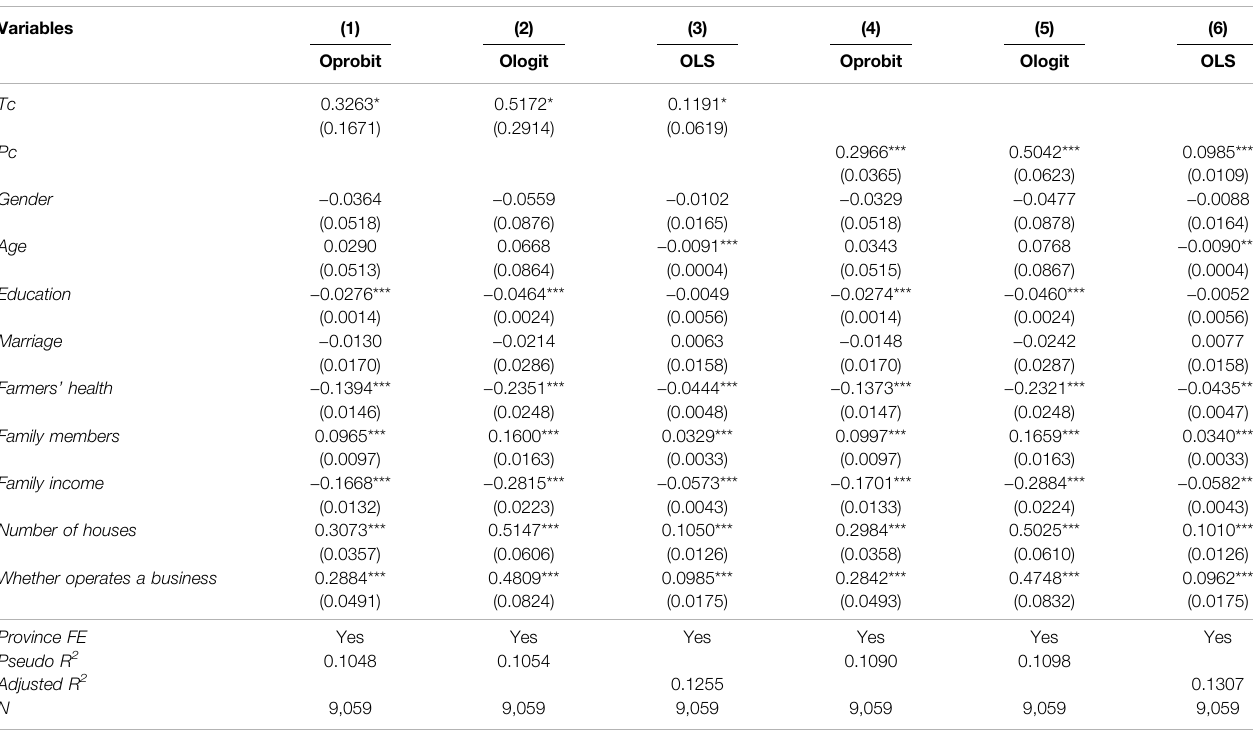
TABLE 3 | Robustness test results: changing models.